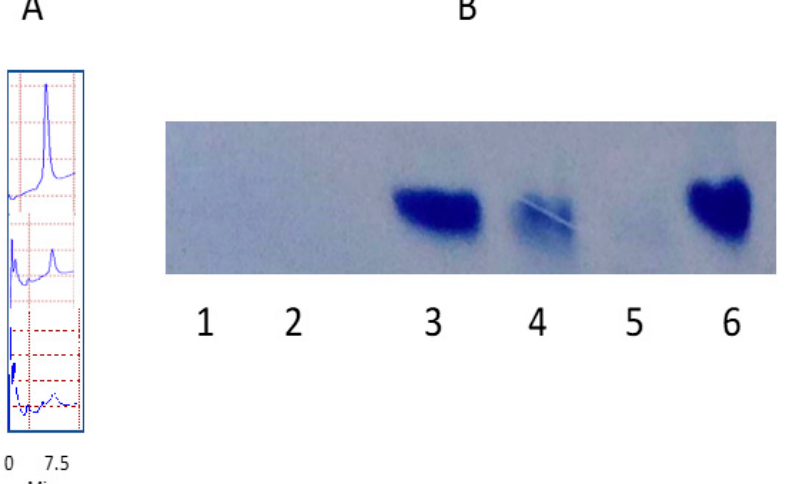
Figure 5. Degradation of G4-90/10 as shown by RP-HPLC ( A ) and acidic native PAGE ( B ). The top HPLC trace is the unreacted G4-90/10, the middle trace is the G4-90/10 reacted with 16 mM H 2 O 2 , and the bottom trace is the dendrimer reacted with 32 mM H 2 O 2 .The dendrimer concentration in all cases was 0.07 mM. In the gel, the dendrimer (0.07 mM) was incubated with 80 mM Fe2+/29 mM H 2 O 2 (lane 1), 50 mM H 2 O 2 (lane 2), 5 mM H 2 O 2 (lane 4), or 500 mM H 2 O 2 (lane 5) in phosphate buffered saline (PBS) for 24 h at 37 ◦ C. Lanes 3 and 6 are the dendrimer controls (0.07 mM).